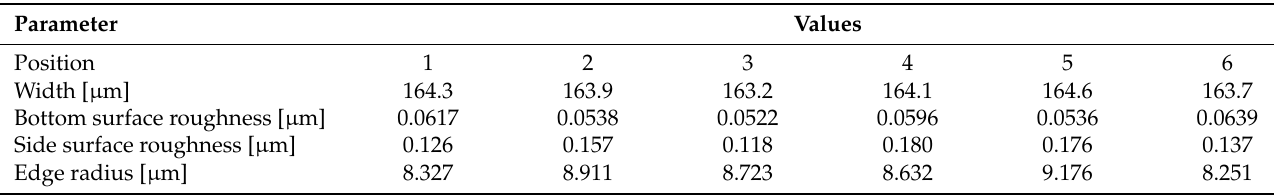
Table 6. Measured values of technical